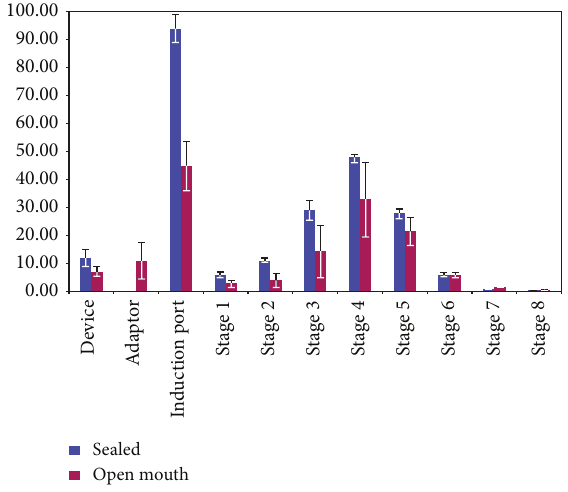
Figure 1: Aerodynamic size distribution (mean ± SD) of a 250 𝜇 g fluticasone propionate pMDI (Flixotide Evohaler) at 30 L/min: open ( 𝑛 = 6 ); sealed ( 𝑛 = 4